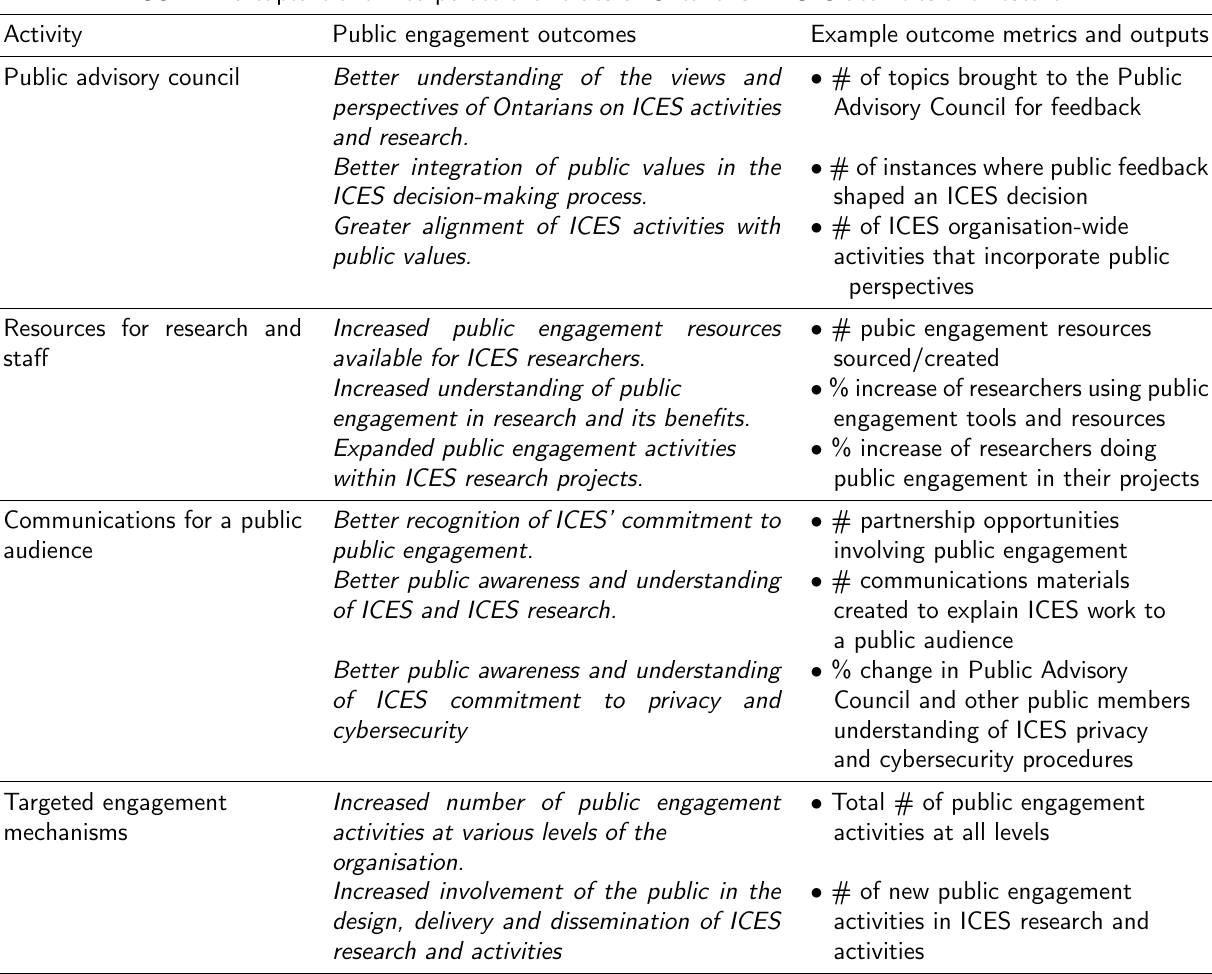
Table 1: ICES public engagement strategy evaluation framework GOAL: To capture and incorporate the values of Ontarians in ICES activities and